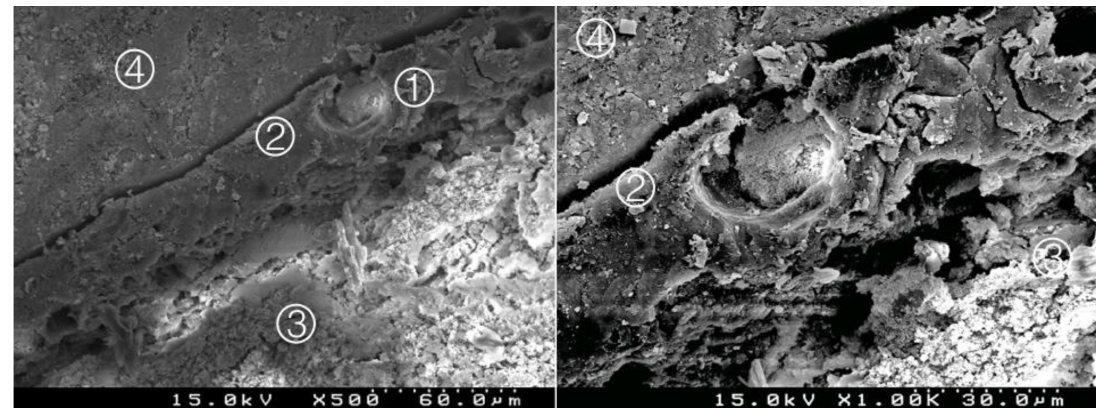
Figure 16. Group 14 (NeoMTAU07): interdigitation between the adhesive and cement. An interfacial gap and a less deep interdiffusion layer are observed 1 (cid:13) between the adhesive 2 (cid:13) and the NuSmile ® NeoMTA 3 (cid:13) . Composite resin 4 (cid:13) (original magnification 500 × and 1000 × ).